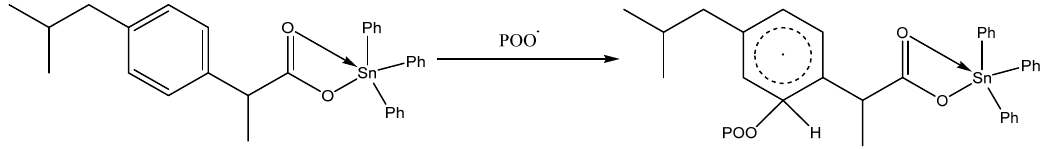
Figure 13. Photo-stabilizers act as radical scavengers.